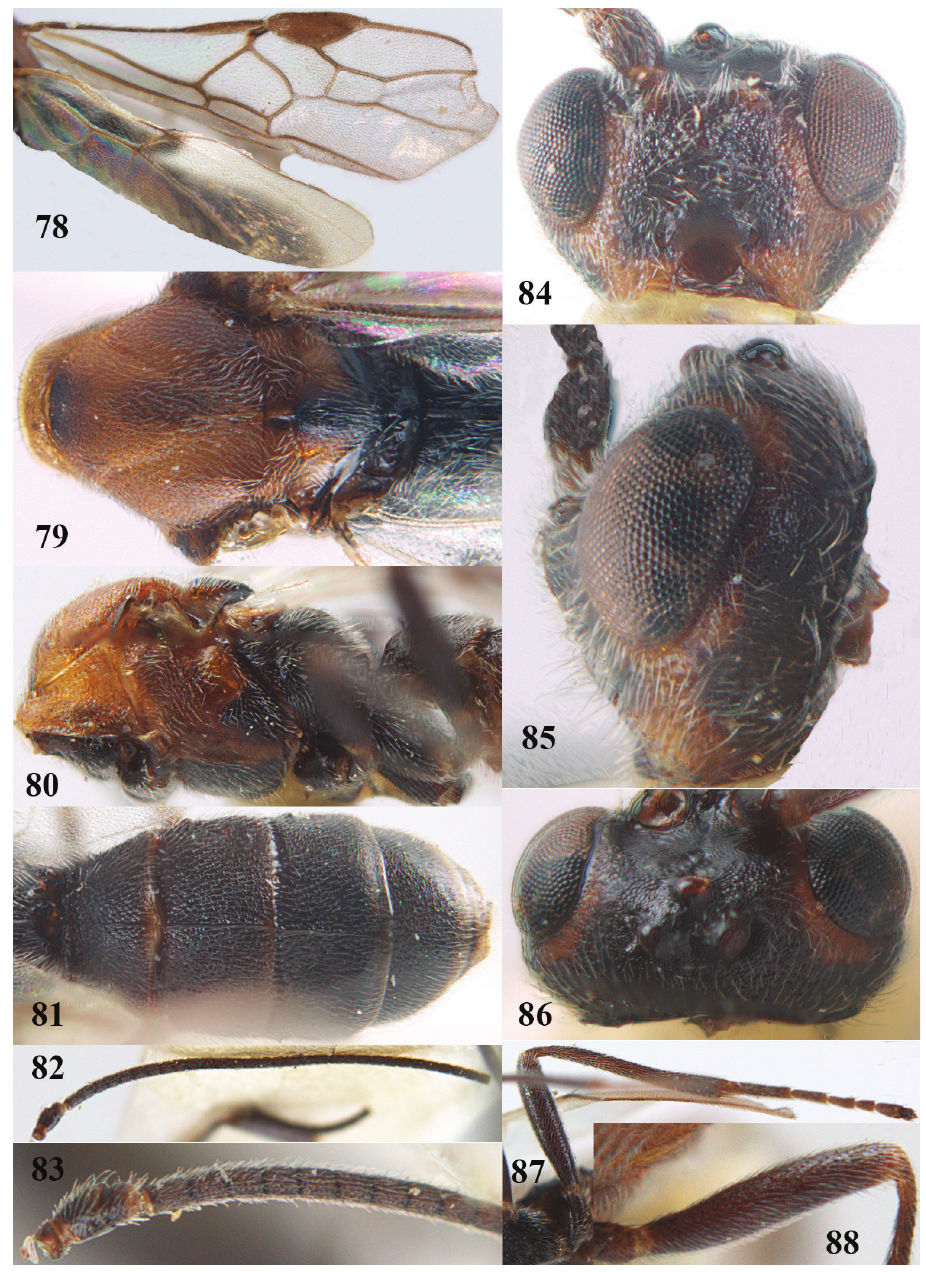
Figures 78–88. Aleiodes artesiariae sp. n., ♀ , holotype. 78 wings 79 mesosoma dorsal 80 mesosoma lat- eral 81 metasoma dorsal 82 antenna (incomplete) 83 basal segments of antenna 84 head anterior 85 head lateral 86 head dorsal 87 hind leg lateral 88 fore femur